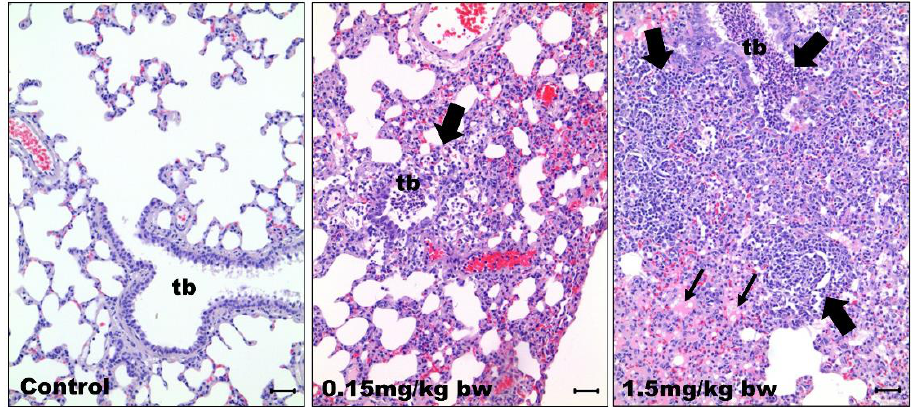
Figure 4. Histopathological observations in lungs of rats exposed to CuO NPs. Lung tissues were fixed in 10% formalin and then embedded in paraffin. Tissue slides of 3- μm -thick sections were stained with hematoxylin and eosin and then visualized via light microscopy: control group (saline as vehicle only); 0.15 mg/kg bw CuO NPs; 1.5 mg/kg bw CuO NPs; tb: terminal bronchiole; thick arrow: accumulation and infiltration of neutrophils and mononuclear cells; thin arrow: alveolar spaces filled with edematous fluid. Bars = 50 µ m.